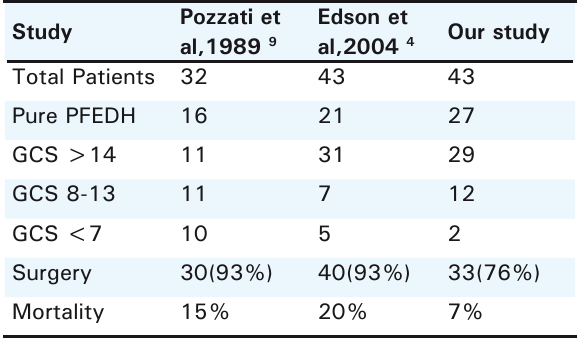
table 7. Comparison of results